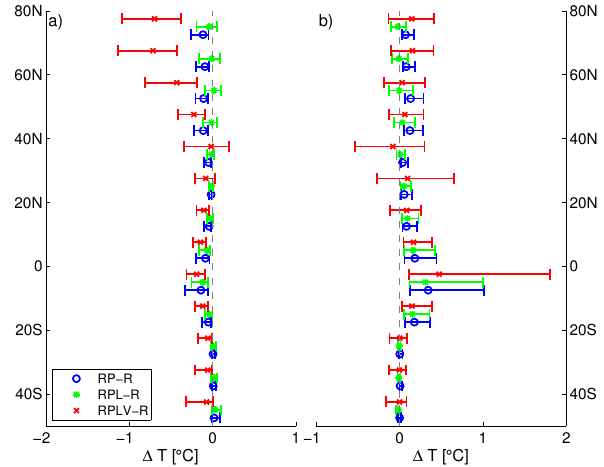
Fig. 7. Zonal annual land temperature anomalies relative to R for RP (blue), RPL (green) and RPLV (red) experiments for CO 2 of 140ppm (a) and 560ppm (b) . Shown are the median and the 5–95 percentile range of the